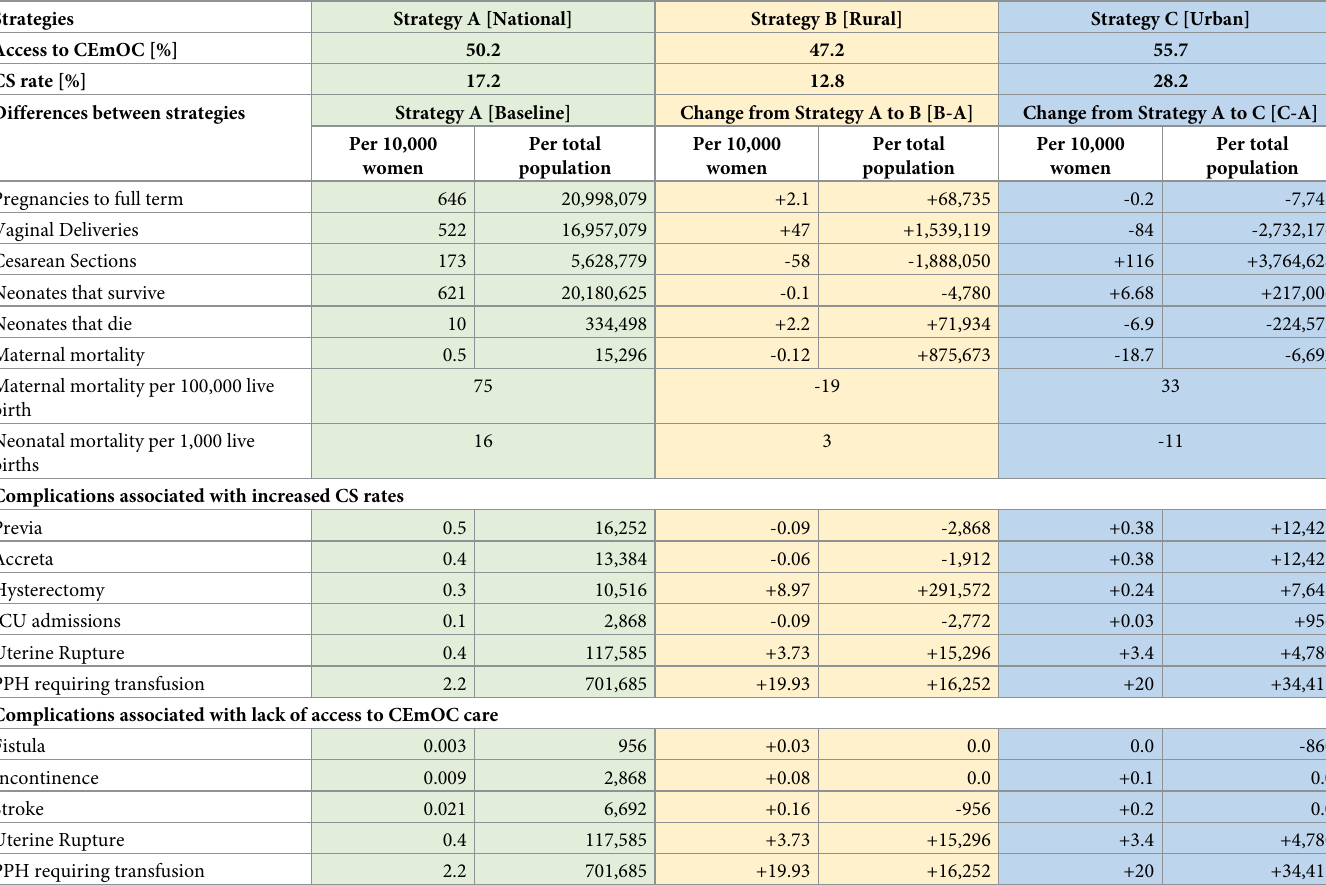
Table 2. Events per 10,000 women during their reproductive lifetime and estimates for the entire female population in